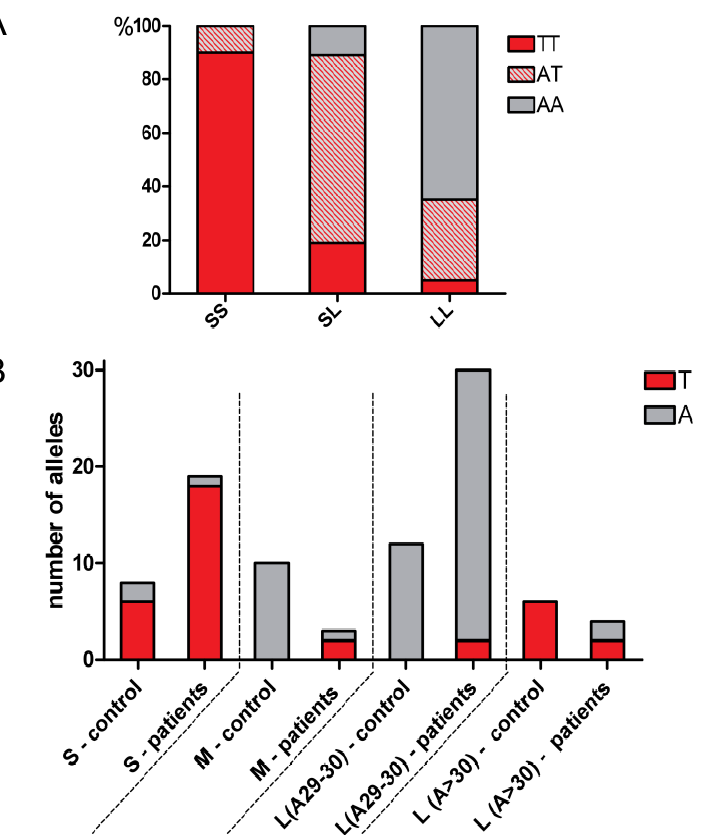
Figure 2. Co-segregation of the A and T alleles with HMOX1 promoter length variants: ( A ) Shown as a percentage frequency distribution of AA, AT and TT genotype in SS, SL and LL individuals (both patients and control group); ( B ) distribution of AA and TT in individuals with certain length variants, separately in the patient and control group; S—short alleles (GT n < 24), M—medium alleles (24–28 GT n), L—long alleles (29/30 GT n), L—very long alleles (GT n > 30).